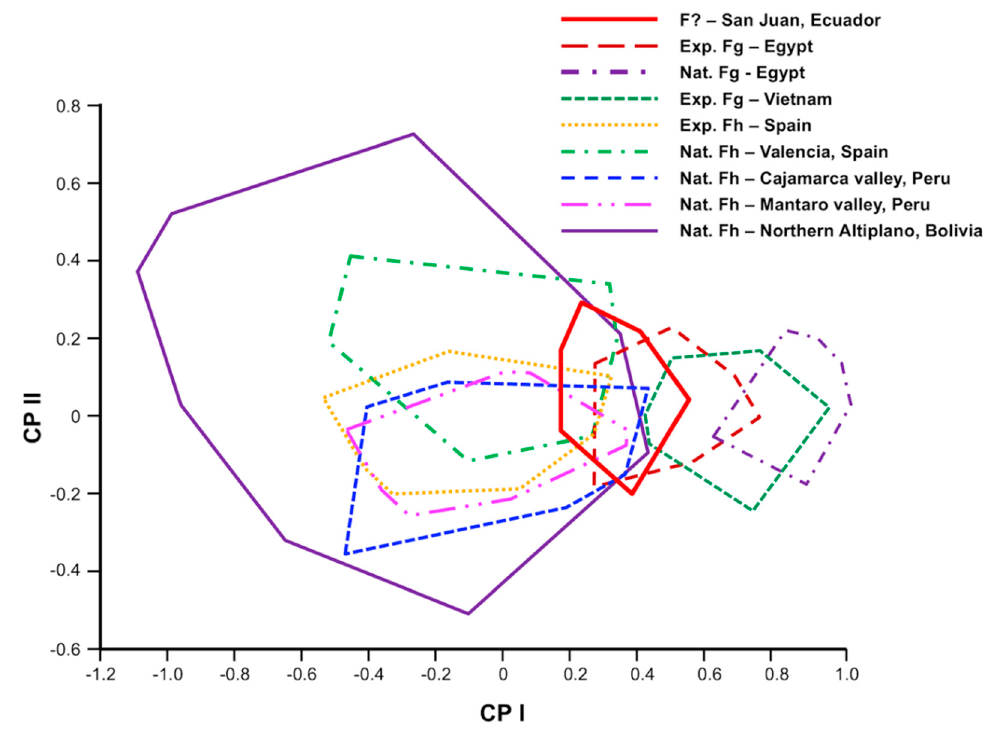
Figure 4. Factor map for the comparison of Fasciola specimens found naturally infecting sheep in San Juan in Ecuador (nEc), with F. hepatica specimens from Cajamarca (nCaj) and Mantaro (nMan) valleys in Peru, Northern Altiplano (nAlt) in Bolivia, and Valencia (nSp) in Spain, as well as with F. hepatica (Spanish isolate - expSp) and F. gigantica (Egyptian isolate - expEg, and Vietnamese isolate - expVi) from experimentally infected Guirra sheep. Samples are projected onto the first (PC1, 69%) and second (PC2, 11%) principal components. Each group is represented by its perimeter.